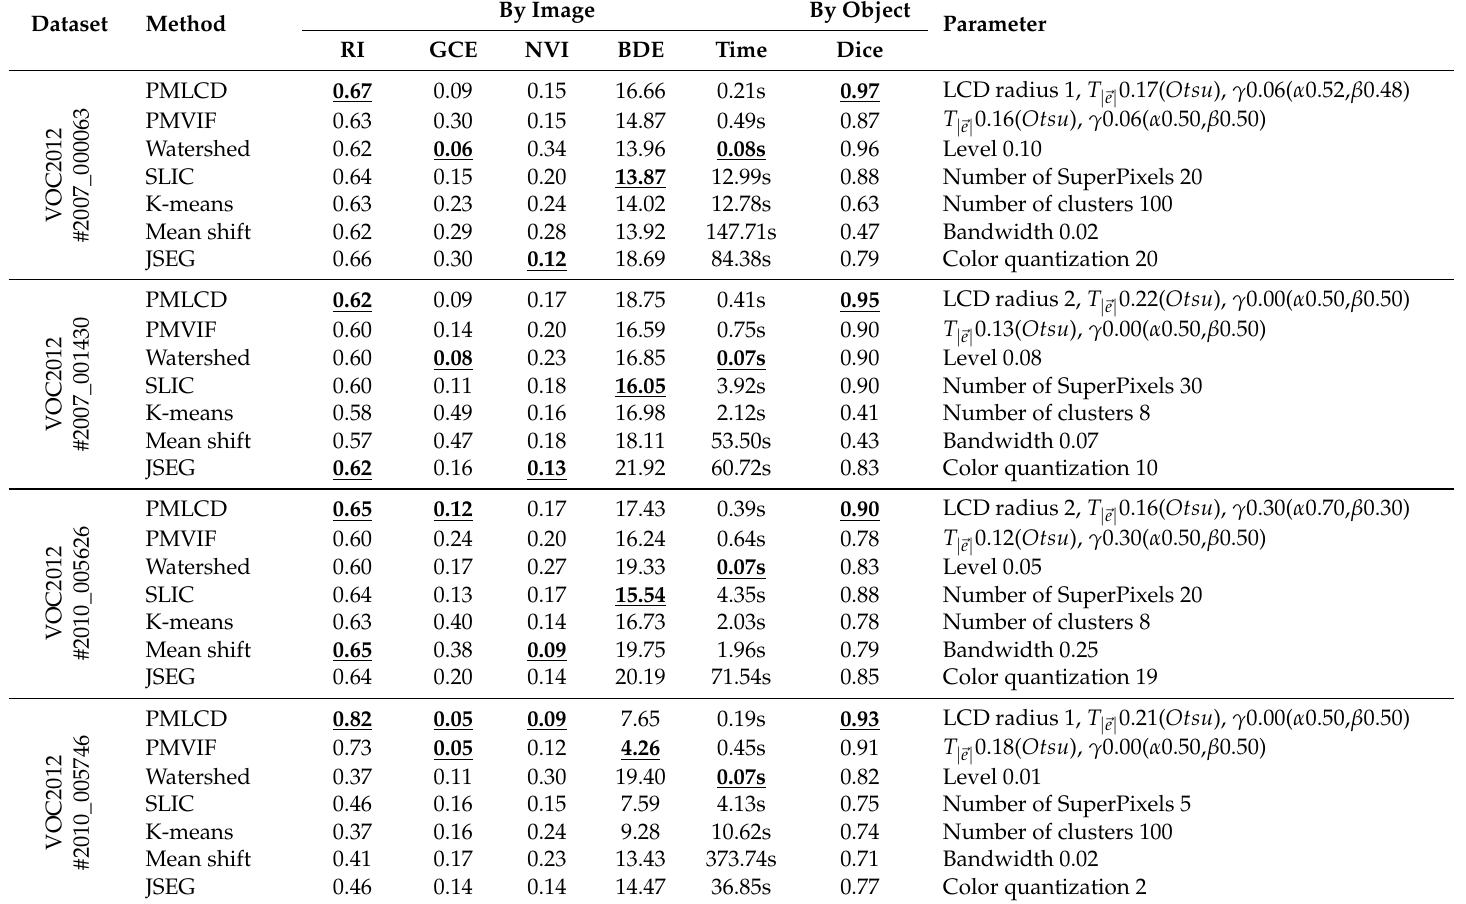
Table 1. The performance of each method from Figures